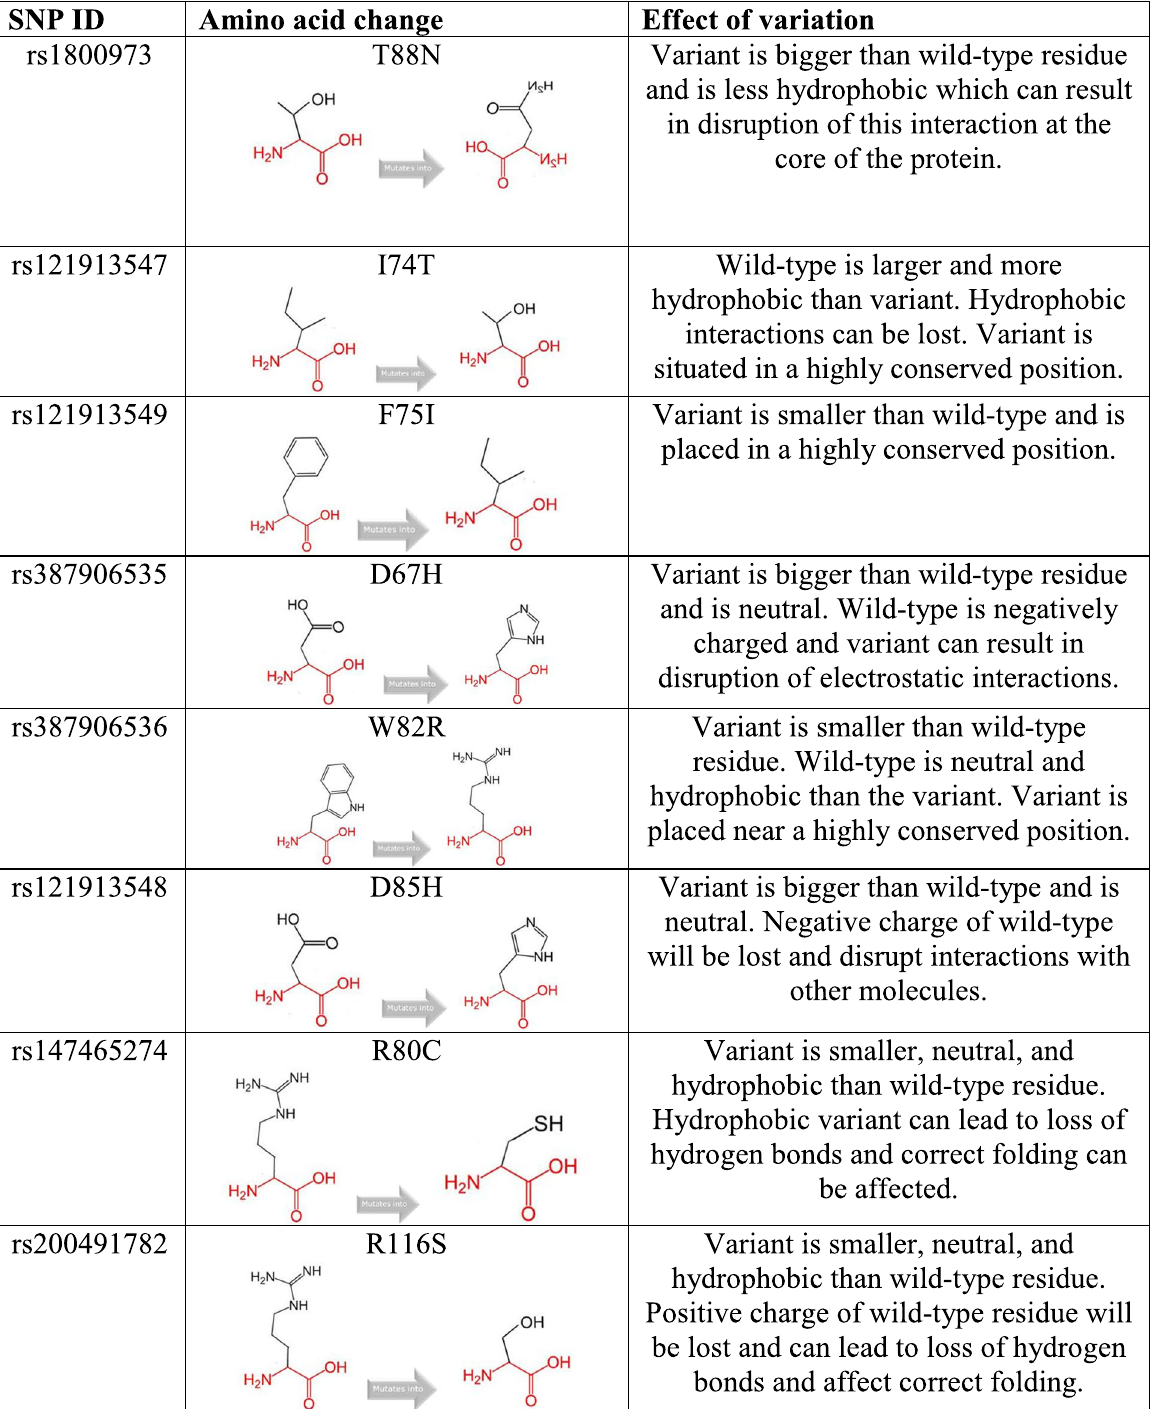
Table 4 Effect of polymorphism as analyzed by HOPE